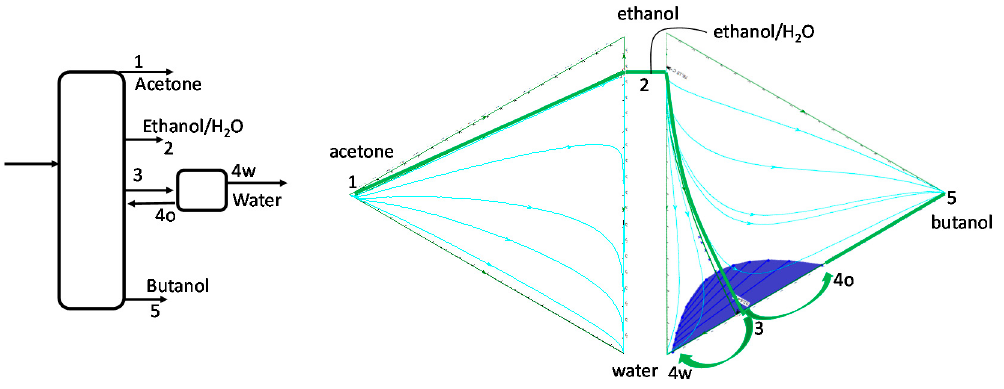
Figure 12. Feasibility of the separation of ABE mixture in a single distillation column.